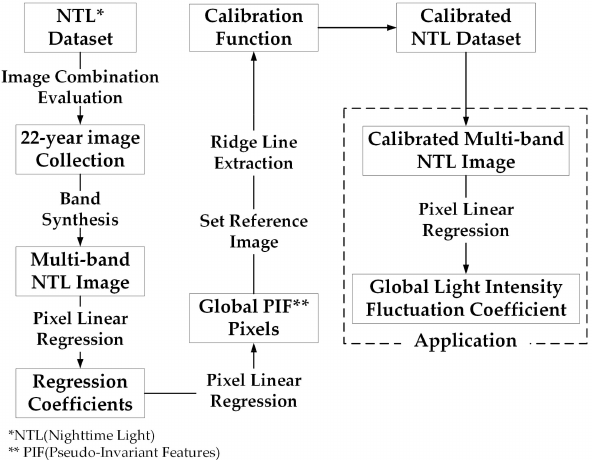
Figure 1. The technical flow chart of PBPIF-based interannual